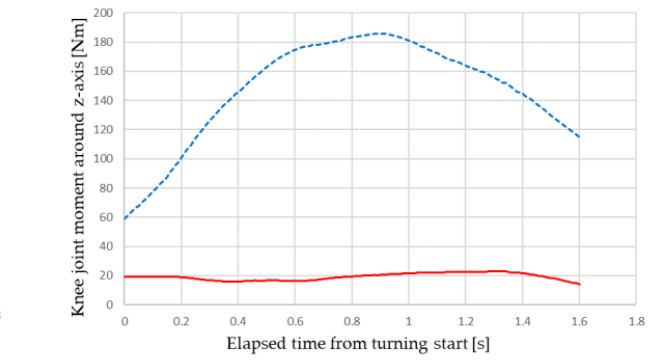
2.387 Nm (SE = 0.037) during automatic driving. The values for the foot outside the turn direction are 3.162 Nm (SE = 0.046) for manual driving and 3.718 Nm (SE = 0.038) for automatic driving. The results of a paired-sample t -test show a significant difference (*) in the mean values of joint moments between the ankles inside and outside the turn directions,